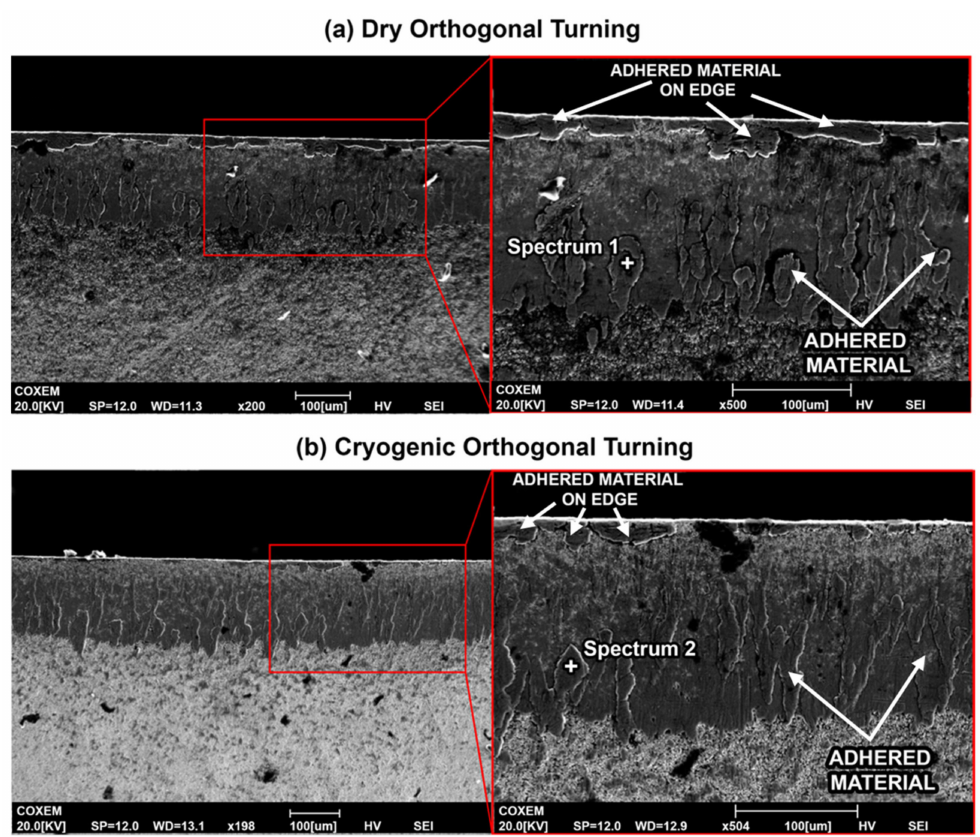
Figure 12. SEM images of the rake face of the ( a ) dry insert and ( b ) optimal cryogenic